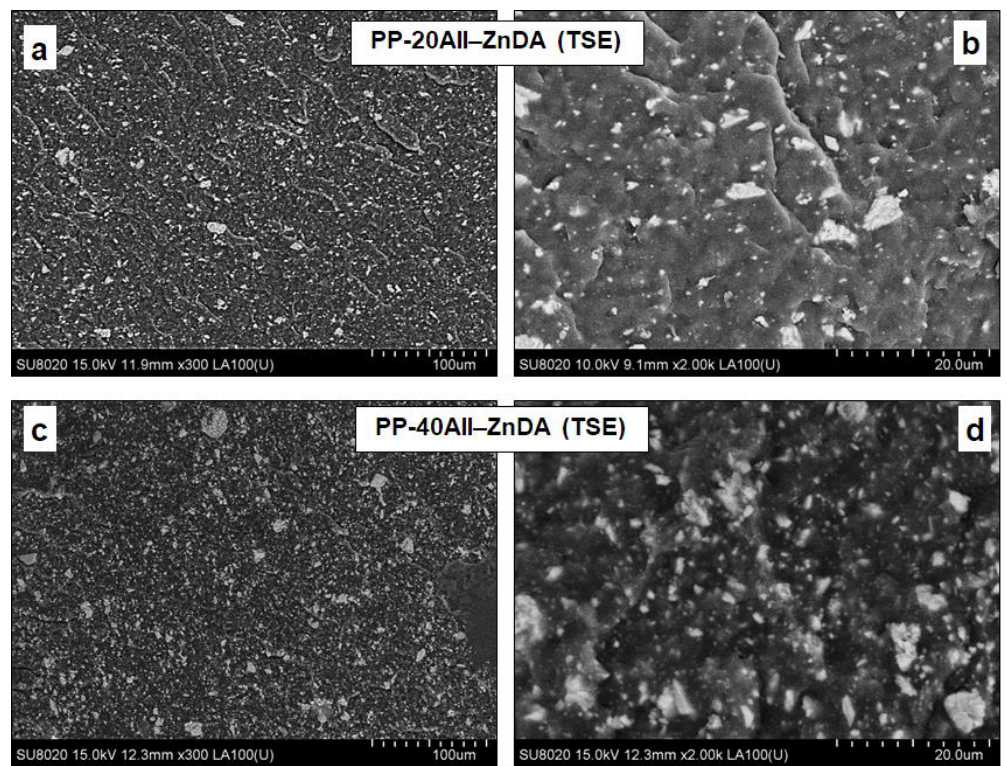
Figure 9. ( a – d ). SEM (LA-BSE) pictures at different magnifications on cryo-fractured surfaces of PP –